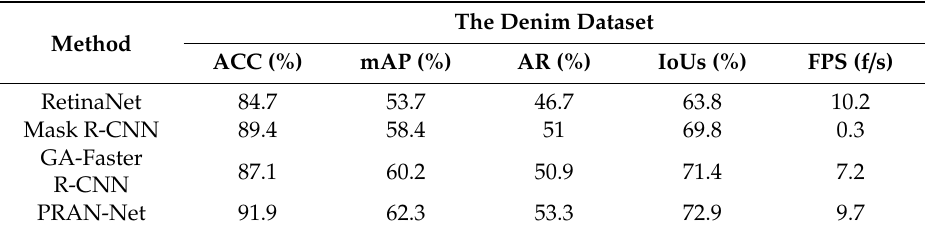
Table 3. The detection results of the four methods with the denim